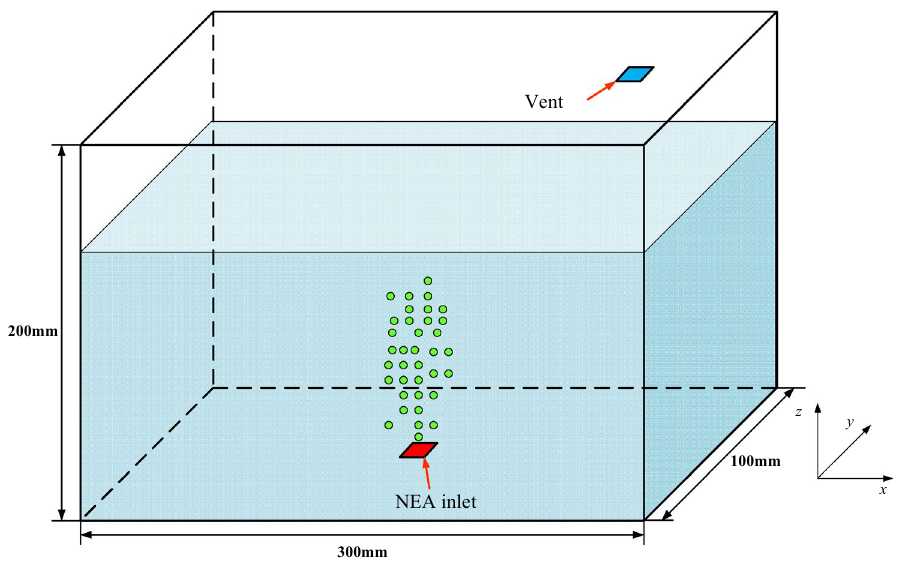
Figure 1. Schematic diagram of the scaled fuel